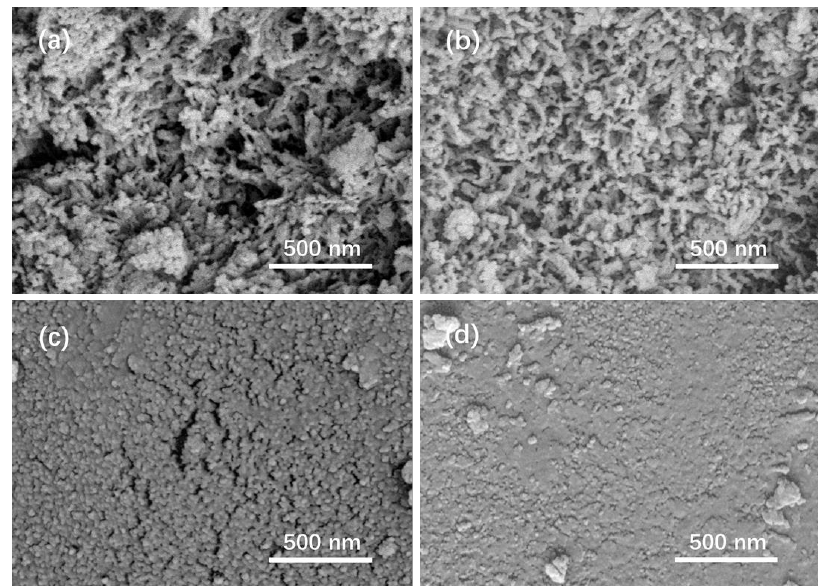
Figure 9. SEM image of the glass samples after immersion in K 2 HPO 4 solutions with ( a ) initial pH = 9, ( b ) initial pH = 7, ( c ) initial pH = 5, and ( d ) initial pH = 3 for 20 days.